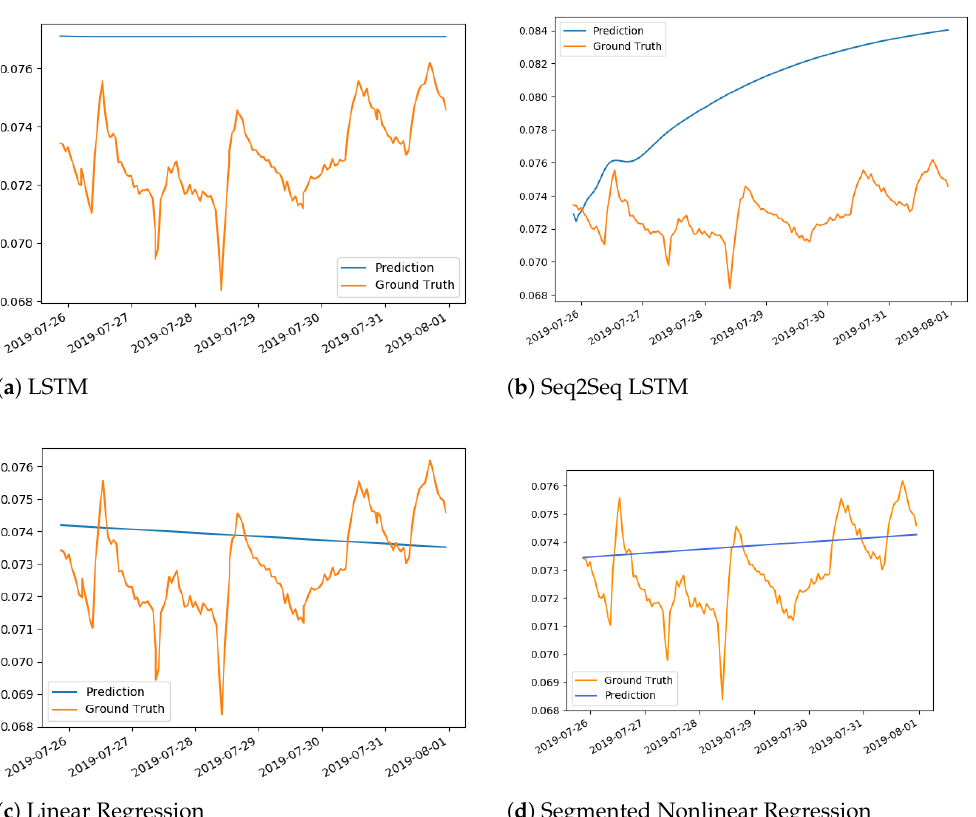
Figure 6. Evaluation of each model on Crack A2 test